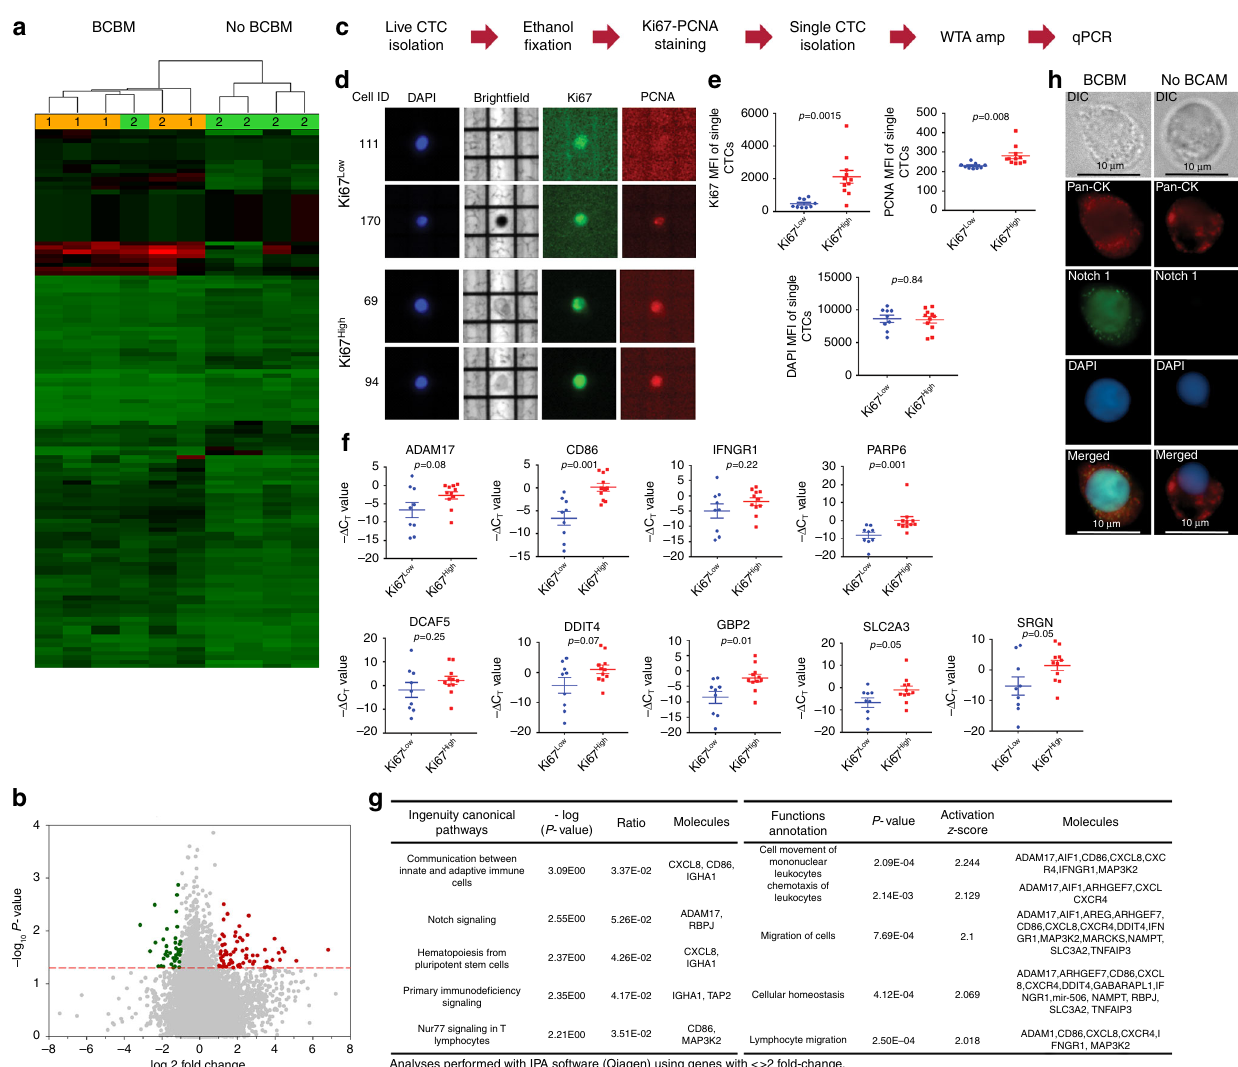
Figure 4 Difference in transcriptomic signatures of BCBM vs. no BCBM CTCs. a Heat map showing CTC transcriptomes in BCBM ( n = 5) vs. no BCBM ( n = 5). Clustering was performed using genes with fold-change < − 2 or > 2, ANOVA p -value < 0.05. Of note, a 126-gene signature was found, of which 73 genes were upregulated and 53 genes were downregulated. Patient# 3 (no BCBM clustering with BCBM) expired before the study results were obtained and could not be followed-up. b Volcano plot showing the global gene expression changes in CTC isolated from blood of BCBM vs. no BCBM cases. c Work fl ow for isolating single Ki67 Low and Ki67 High CTCs. d Representative images showing Ki67, PCNA, and DAPI staining in single CTCs. All 20 single CTCs are shown in Supplementary Fig. 6. e Mean fl uorescence intensity of Ki67, PCNA, and DAPI in isolated single CTCs designated as Ki67 Low ( n = 9) vs. Ki67 High ( n = 11). p- values calculated by unpaired t -test. Of note, both Ki67 and PCNA staining are signi fi cantly higher in Ki67 High CTCs, whereas DAPI staining intensity is similar. f qPCR analyses showing gene expression levels in single CTCs. p- values calculated by unpaired t -test. g Activated canonical pathways and cellular functions in BCBM CTCs. h Representative images showing Notch1 staining in PanCK+ CTCs isolated from blood of BCBM and no BCBM patients. Scale bar = 10 μ m. Error bars represent